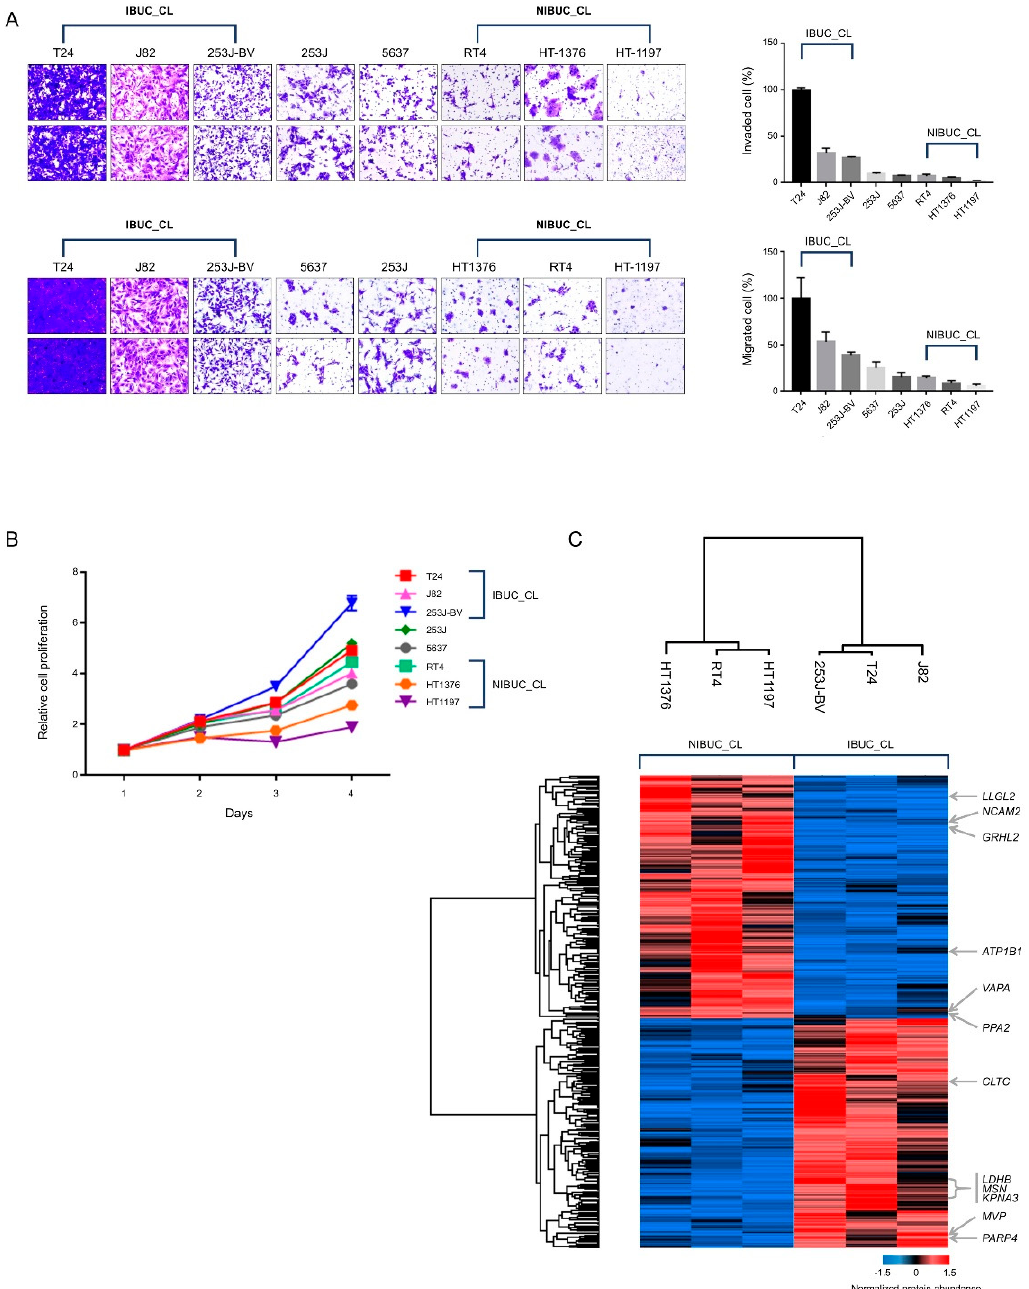
Figure 2. Bladder urothelial carcinoma (BUC) cell line results. ( A ) Invasion and migration Assay. ( B ) Proliferation assay. ( C ) Hierarchical clustering of differentially expressed proteins (DEPs) between invasive bladder urothelial carcinoma cell line (IBUC_CL) and non-invasive bladder urothelial carcinoma cell line (NIBUC_CL).